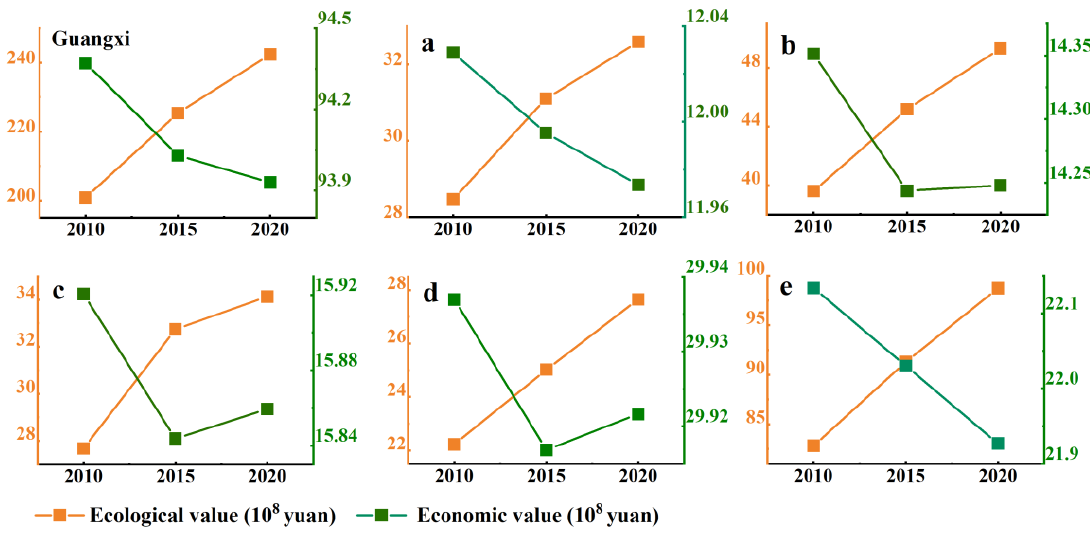
Figure 3. The trend of ecological-economic value changes in Guangxi and each consolidation area. (Note: ( a ) is the middle karst basin area of Guangxi, ( b ) is the southeast plain area of Guangxi, ( c ) is the northeast hilly mountain area of Guangxi, ( d ) is the northwest mountain area of Guangxi, ( e ) is the coastal hilly plain area.)